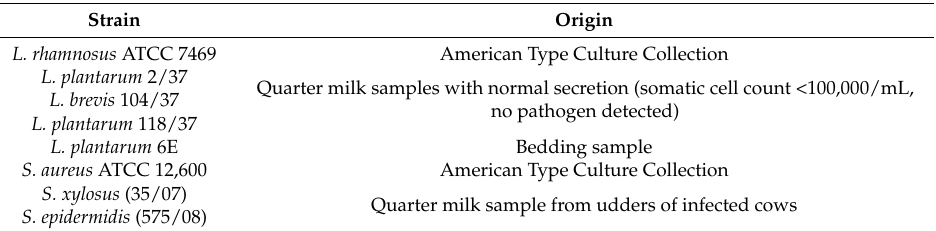
Table 1. Bacterial strains used in this